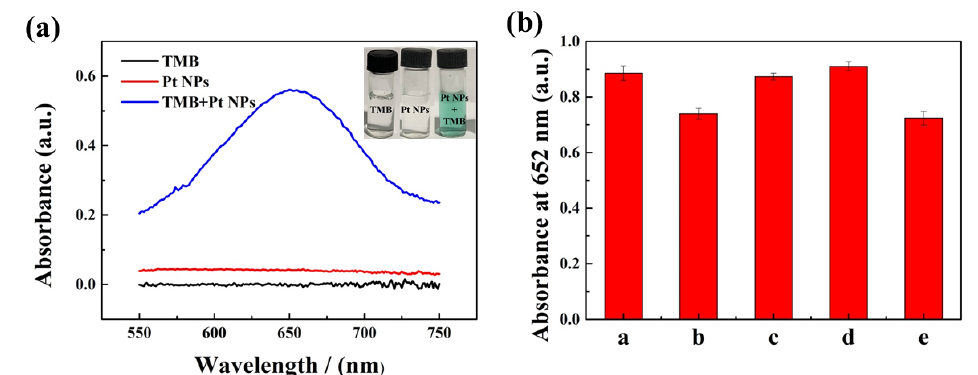
(cid:48) -tetramethylbenzidine (TMB),